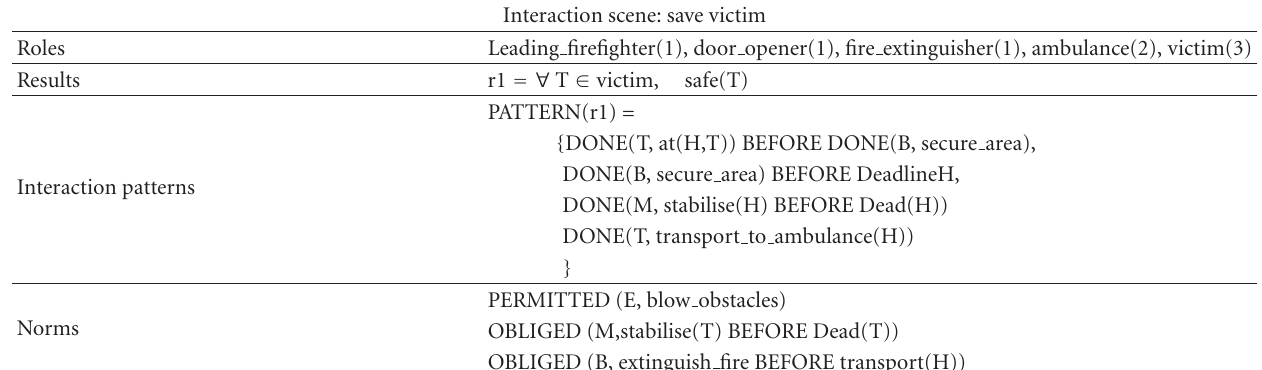
Table 3: Interaction scene in